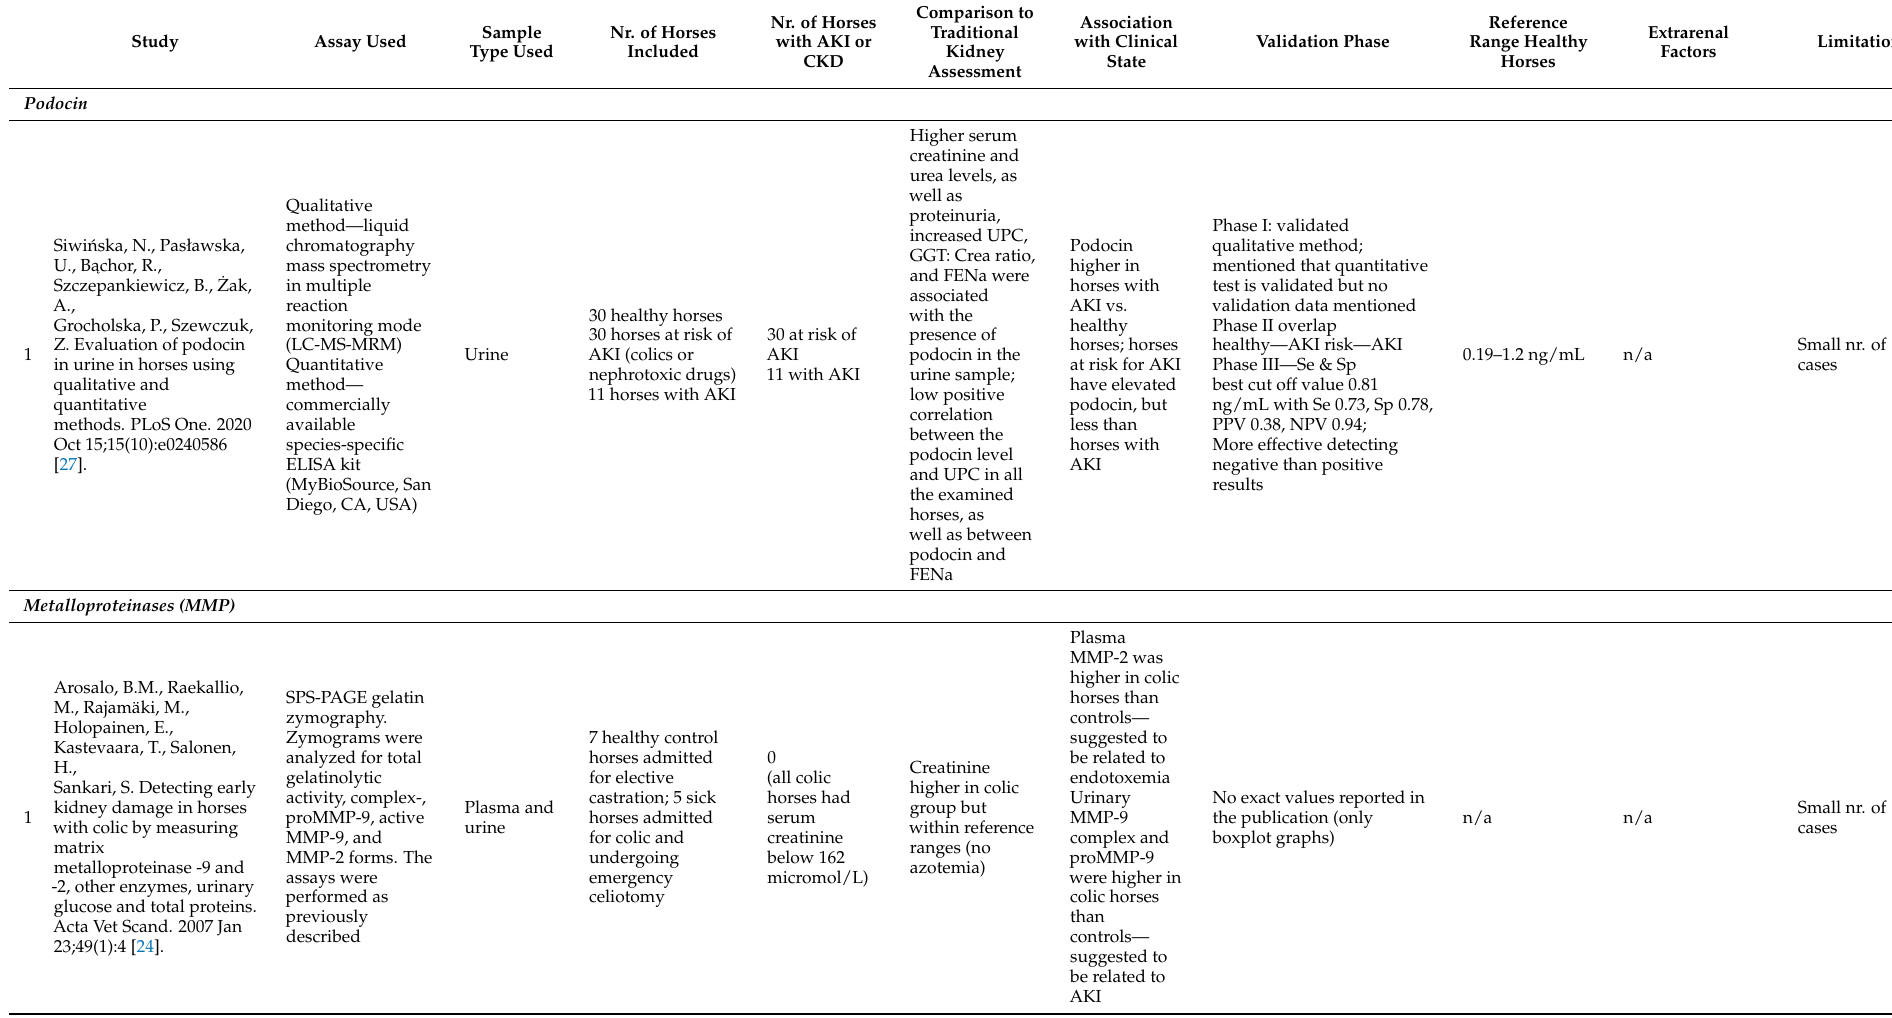
Table 4. List of studies on other biomarkers on kidney disease and their analytical and clinical